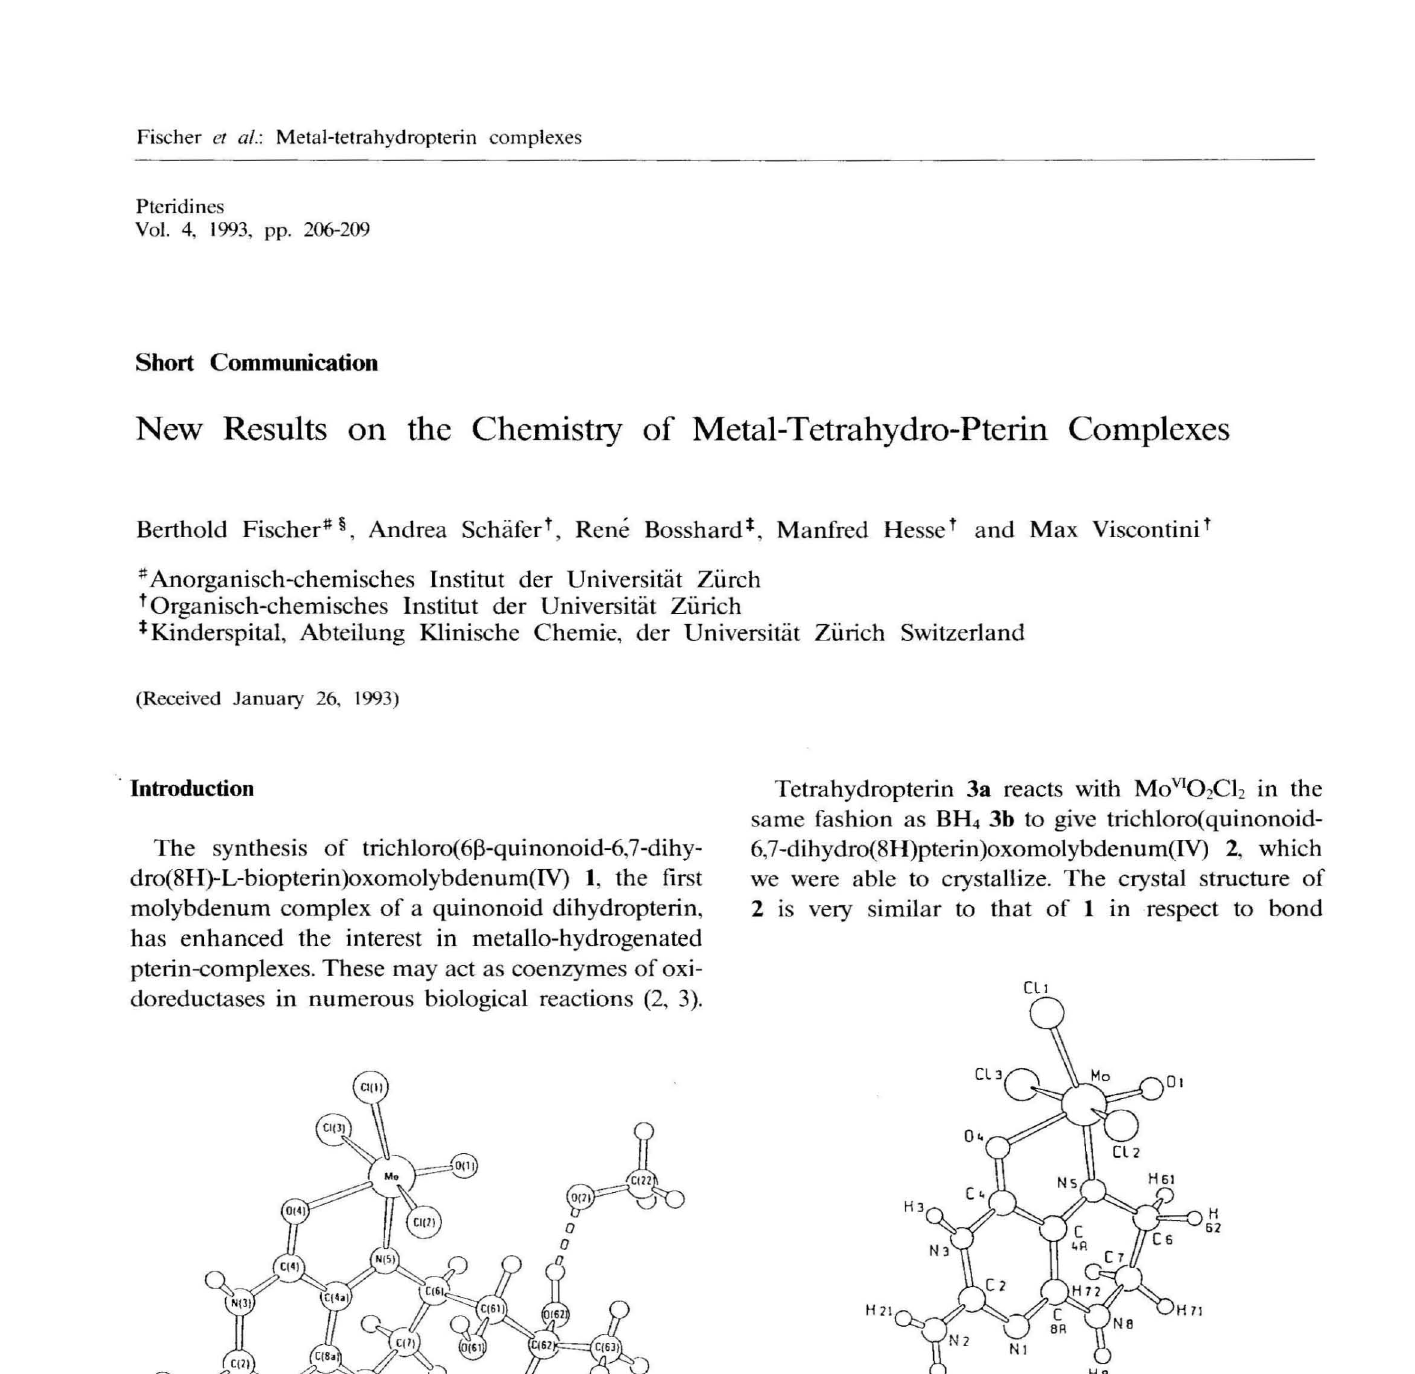
Figure 2. Crystal structure of